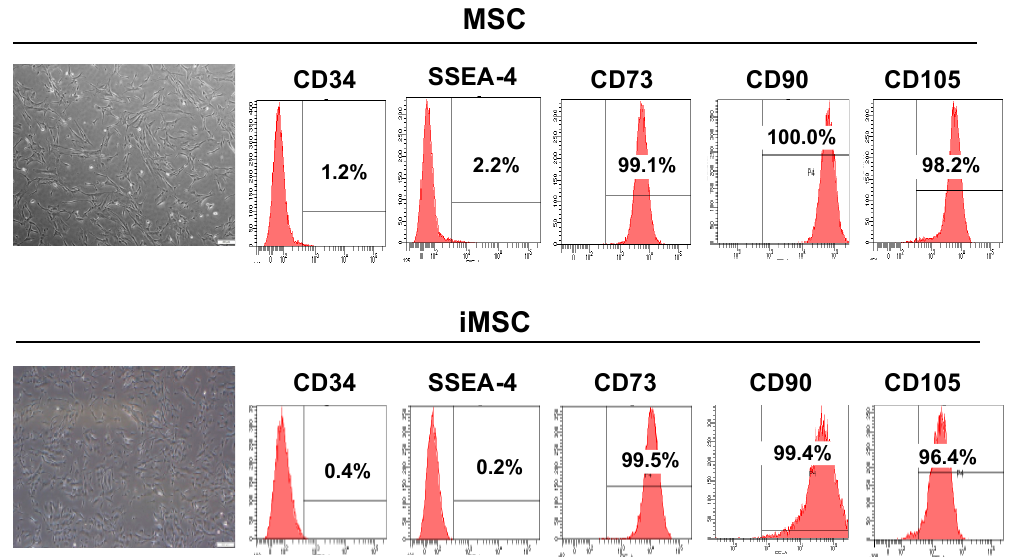
Figure 1. Comparison of the morphology and cell surface marker profile between human Wharton’s jelly MSCs and iMSCs. Both types of cells showed a typical morphology of MSC, with spindle- or fibroblast-like appearance. Flow cytometry analysis showed that both types of cells were positive for MSC markers CD73, CD90, and CD105, but negative for CD34 and SSEA-4. Scale bars are 200 µm.